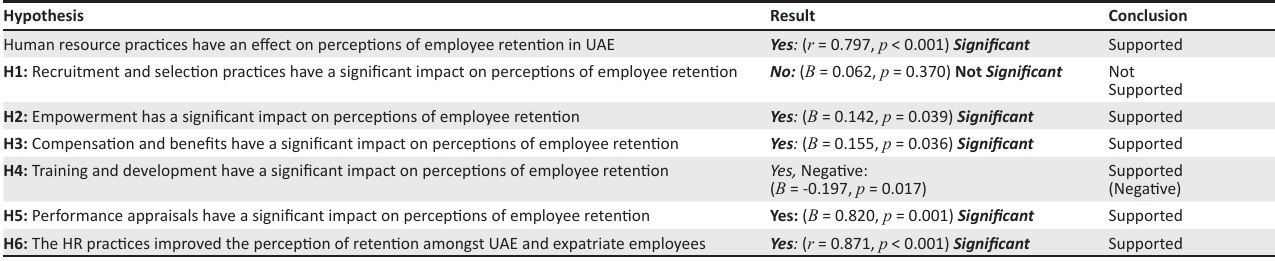
TABLE 6: Hypotheses presentation. Hypothesis Result